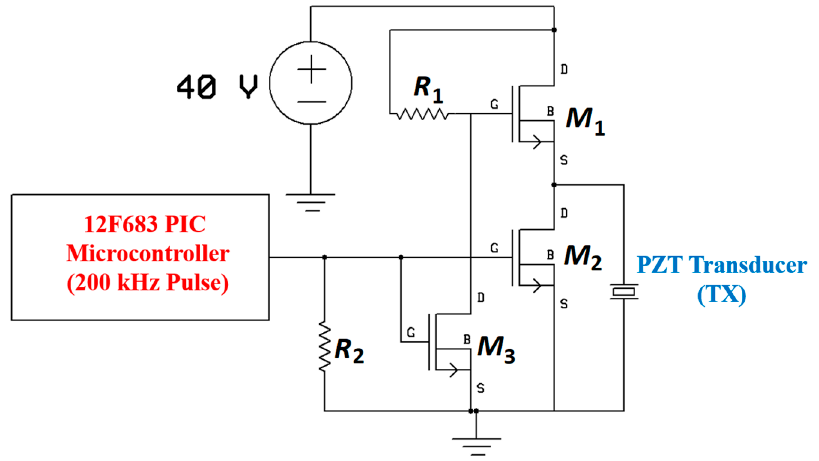
Figure 43. Schematic ofthe piezoelectric (PZT) driver.